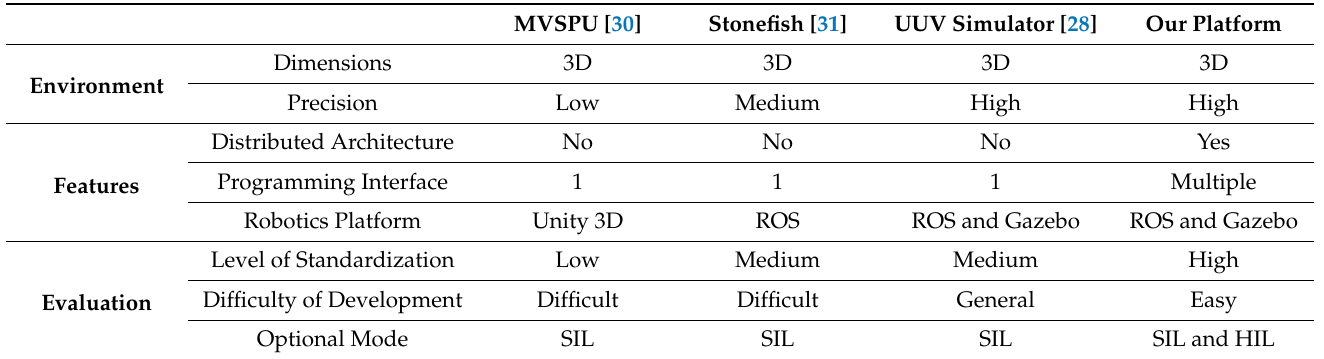
Table 2. Comparison of representative underwater simulation platforms.